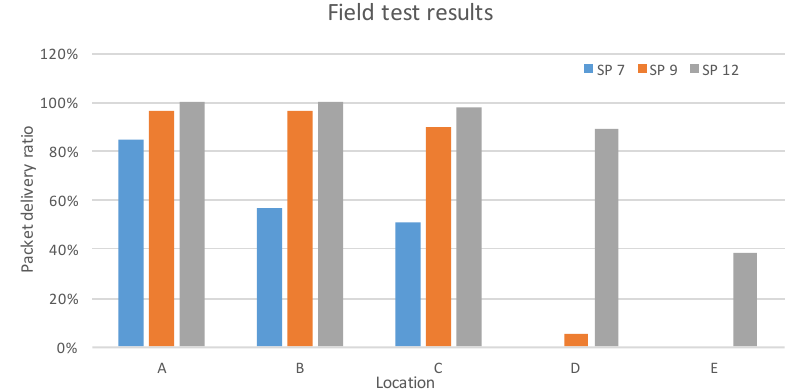
Figure 7. Packet delivery ratio of the LoRa field